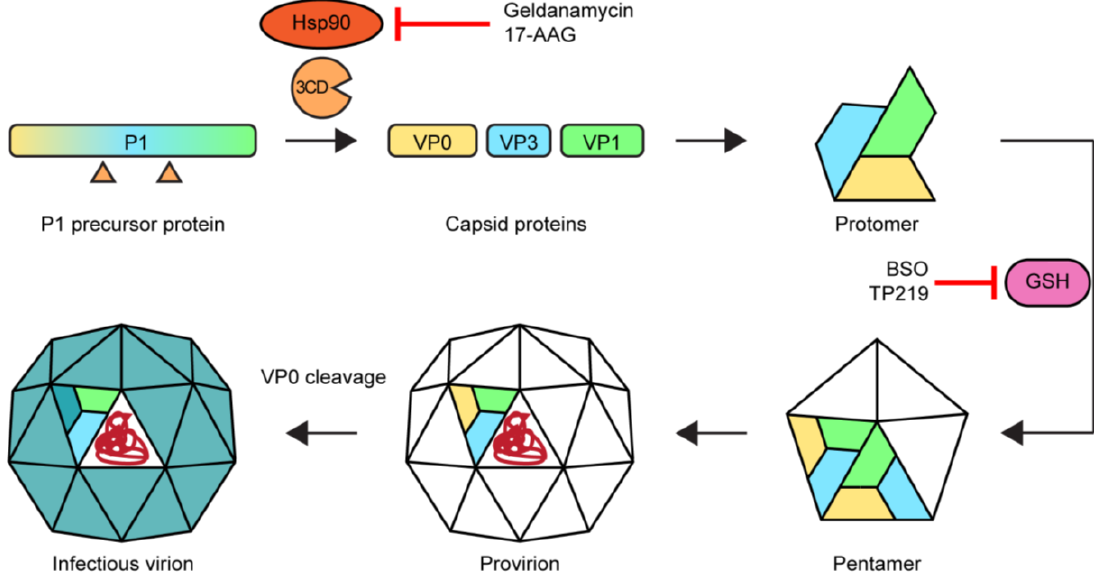
Figure 6. Morphogenesis of enteroviruses and targets for assembly inhibitors. Hsp90 ensures the proper folding of the P1 precursor protein enabling the cleavage by 3CD pro into capsid proteins VP0, VP3, and VP1 which then form protomers. For part of the EVs, glutathione (GSH) is required either for the transition of protomers into pentamers or for the stabilization of pentamers. Twelve pentamers plus the viral genome (in red) combine to form a provirion, followed by a maturation step in which the VP0 protein is cleaved into VP4 and VP2. Treatment with Hsp90 inhibitors or glutathione depletors results in impaired morphogenesis.